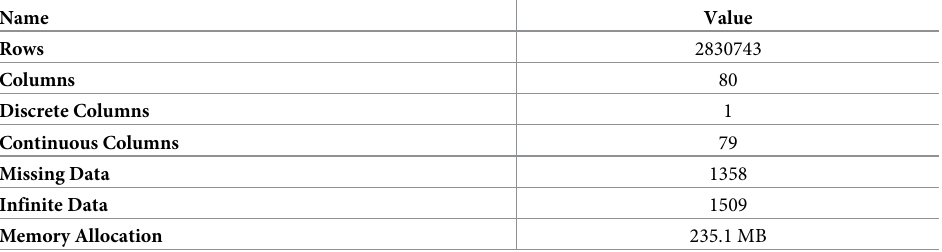
Table 1. Statistical description of the